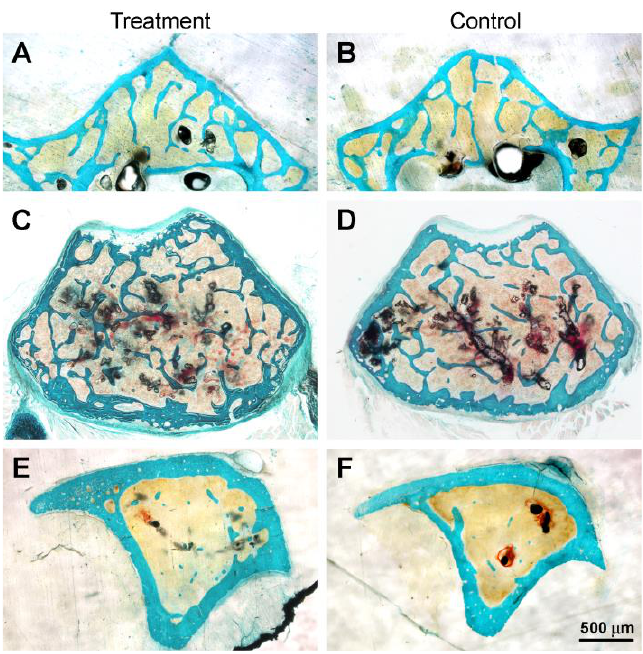
Figure 3. Relative expression of Mg transporters mRNA levels. mRNA was extracted from kidney tissue of mice fed either a normal (control) or a Mg deficient diet (treated) for eight weeks, retro transcribed and amplified by q-PCR. Data (n = 7 for each group) are presented as a bar graph. The relative fold change of MagT1 ( A ), TRPM6 ( B ) and TRPM7 ( C ) mRNA of treated samples vs. controls has been calculated via the 2 ˗ ∆∆ Ct method. GAPDH was used as housekeeping gene; Ct = threshold cycle, ∆Ct = normalized Ct = Ct( Target ) − Ct( GAPDH ) and ΔΔCt = ∆Ct Target (treated sample) − ∆Ct Target (control sample).